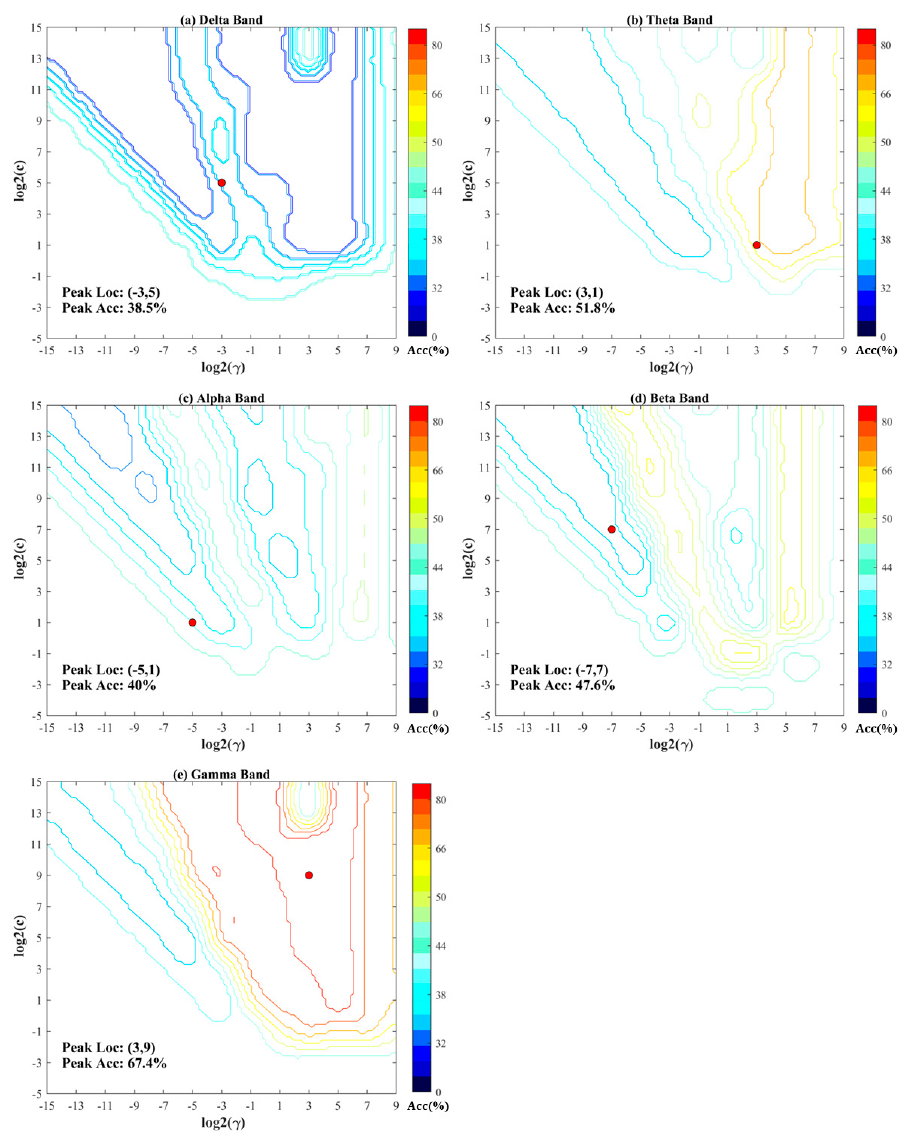
Figure 3. Grid search results of γ and C in the SVM ‐ ML model with RBF kernel using the 62 ‐ channel EEG RSP features of the ( a ) delta, ( b ) theta, ( c ) alpha, ( d ) beta, and ( e ) gamma bands. Acc: accuracy. Peak Acc: highest classification accuracy of the SVM ‐ ML model in the predefined range of ( γ , C); Peak Loc: location ( γ , C) corresponding to the highest classification accuracy of the SVM ‐ ML model.